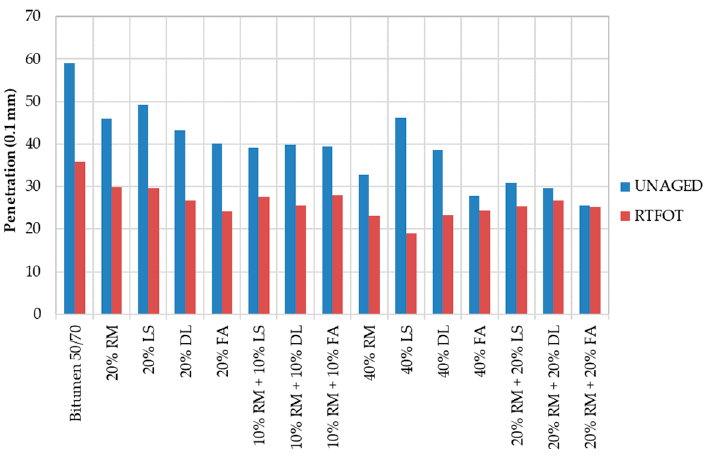
Figure 3. Penetration results for mastics before and after rolling thin film oven test (RTFOT).